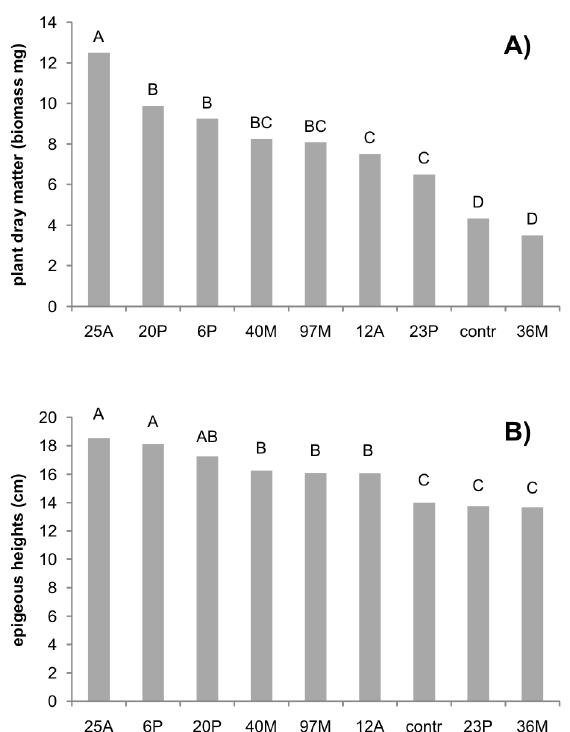
Figure 4. Effect of selected plant-growth-promoting bacteria (PGPB) on durum wheat biomass ( A ) and height ( B ). The letters indicate significant differences ( p < 0.01)